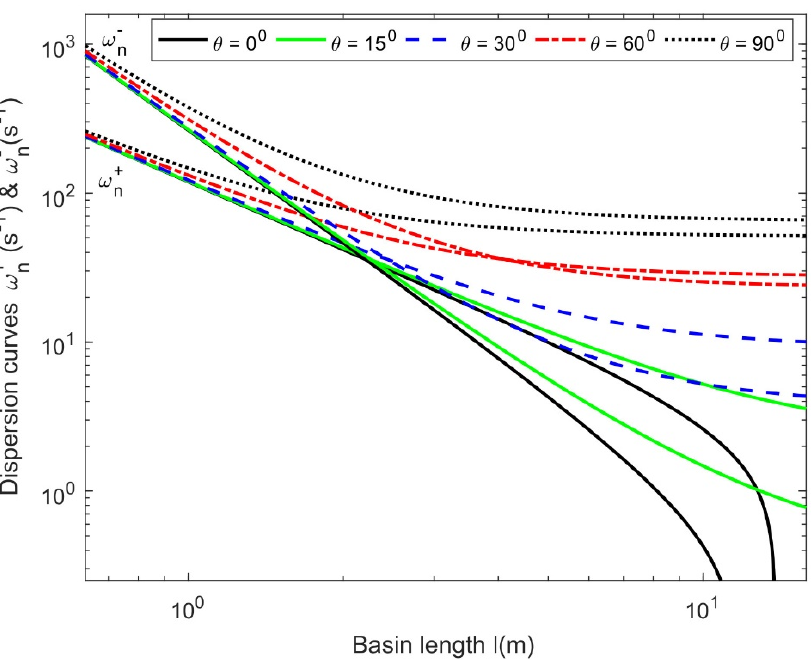
ω − θ ω + , on and against l (m). n n